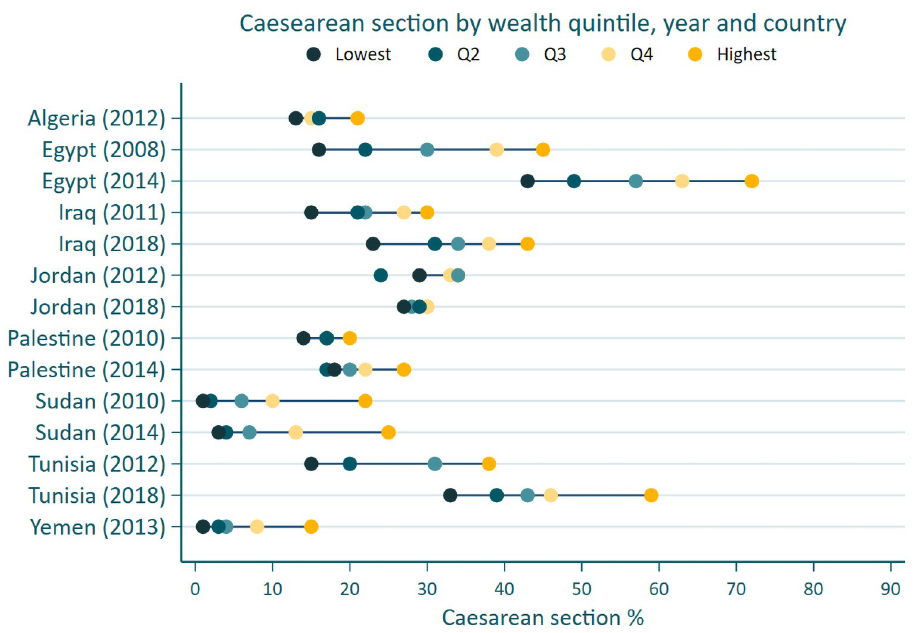
Fig 2. Proportion of caesarean sections by country, survey period and wealth